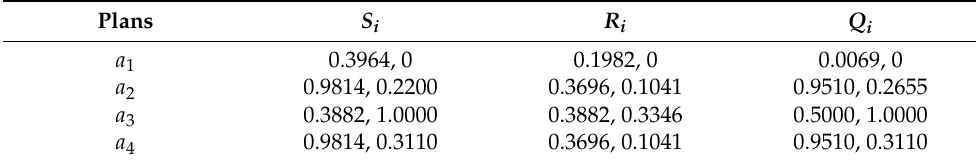
Table 14. The values of S i , R i and Q i of each scheme. Plans